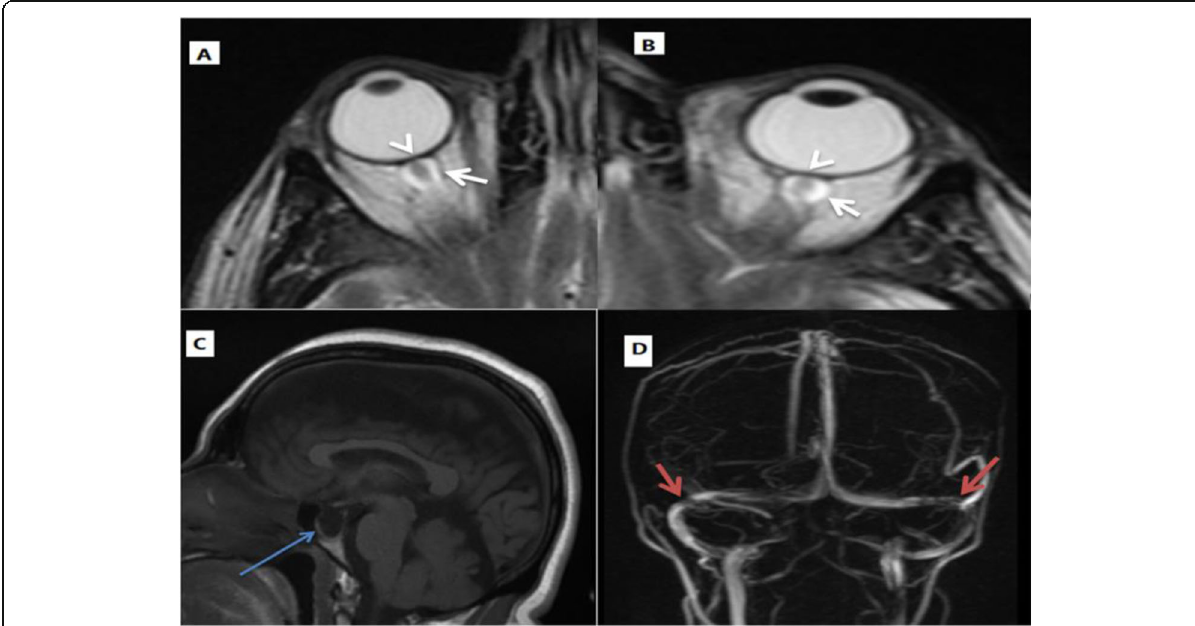
Fig. 2 a – d MRI and MRV of 23 years aged female patient diagnosed with idiopathic increase intracranial tension. a , b Axial T2 scan of both orbits shows grade 2 distention of both optic nerve sheath (white arrows) with bilateral flattened posterior globe (arrowheads). c A mid-sagittal T1 MRI sellar cavity is enlarged with no detected pituitary gland inside grade 5 (empty sella) (blue arrow). d Time of flight MRV shows bilateral transverse sinus stenosis (red arrows) combined conduit score was 1 + 2 =